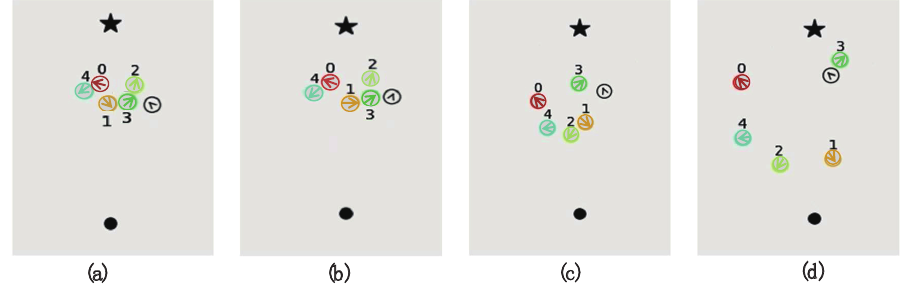
Figure 9. The robot acts by K-step tree planning strategy with different depths. In ( a , b ), the depth is 1 while it is 2 in ( c , d